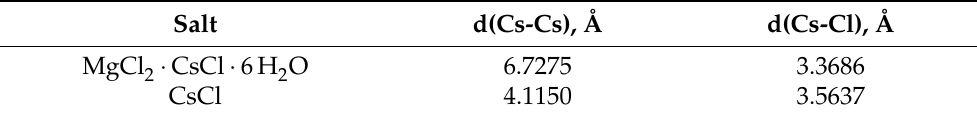
Table 1. The comparison of distances between neighboring atoms for simple CsCl and double salt.